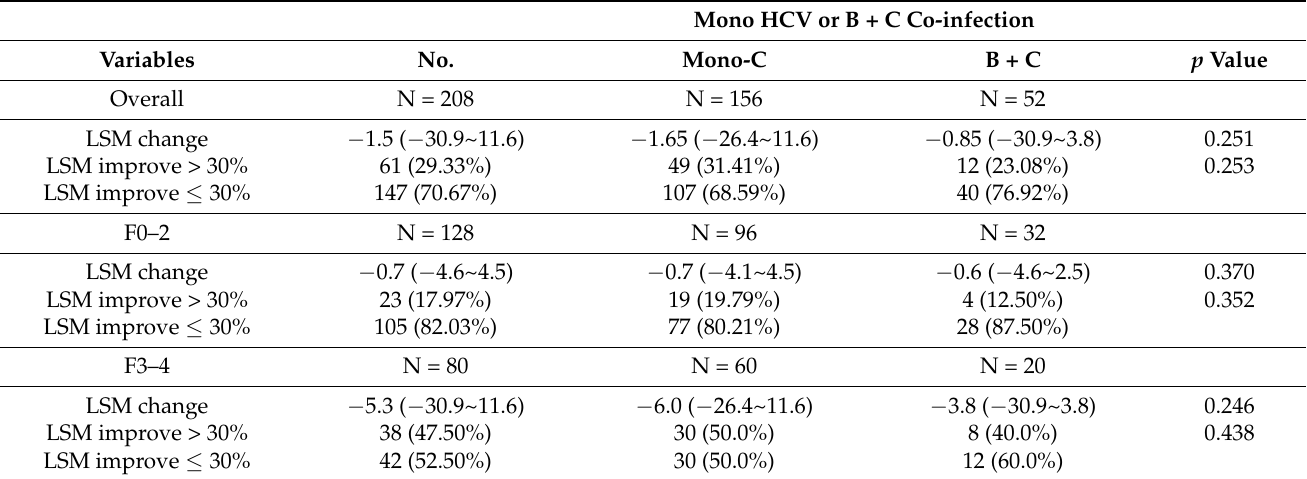
Table 4. Post-treatment demographic comparison after PSM. Stratified by pre-DAA LSM